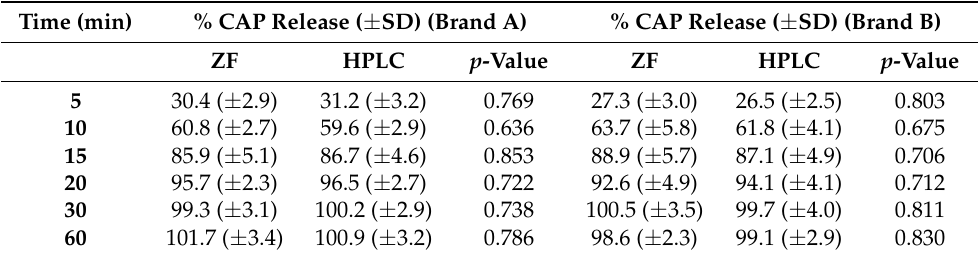
Table 2. Comparison of the dissolution data of the proposed ZF method with USP HPLC